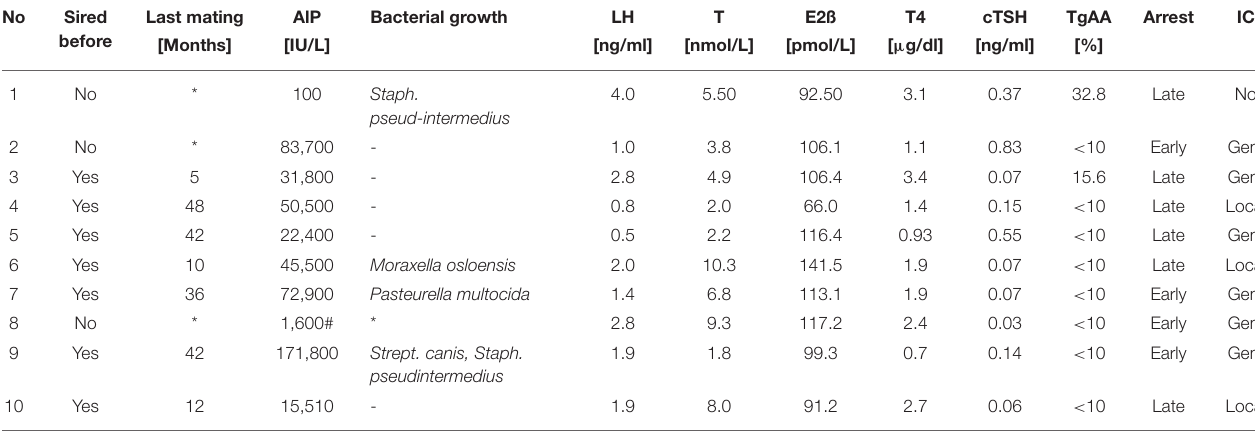
TABLE 1 | Overview about results obtained from individual patients with permanent azoospermia including reproductive history of successful mating (yes/no), months since last successful mating (last mating), activity of alkaline phosphatase (AlP) [IU/l], result of aerobic bacterial culture and results of endocrine analysis: concentrations of luteinizing hormone (LH) [ng/ml], testosterone (T) [nmol/L], estradiol-17ß (E2ß) [pmol/L], thyroxine (T4) [ µ g/dl], canine thyroid-stimulating hormone (cTSH) [ng/ml], thyroglobulin autoantibodies (TgAA) [%]. Additionally, overall result of histological assessment—early or late arrest [arrest (early/late)] as well as infiltration with immune cells (IC: no immune cells [no], focal [focal], and generalized [gen.] immune cell infiltration—was recorded.